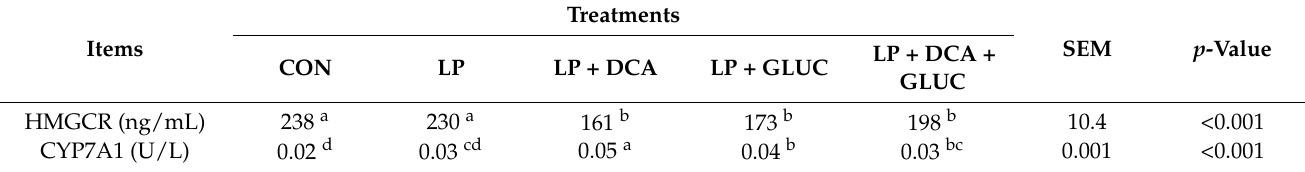
Table 3. Effects of supplementing low protein (LP) diets with sodium dichloroacetate (DCA) and glucose (GLUC) on the enzyme activities in liver tissue of growing-finishing pigs.